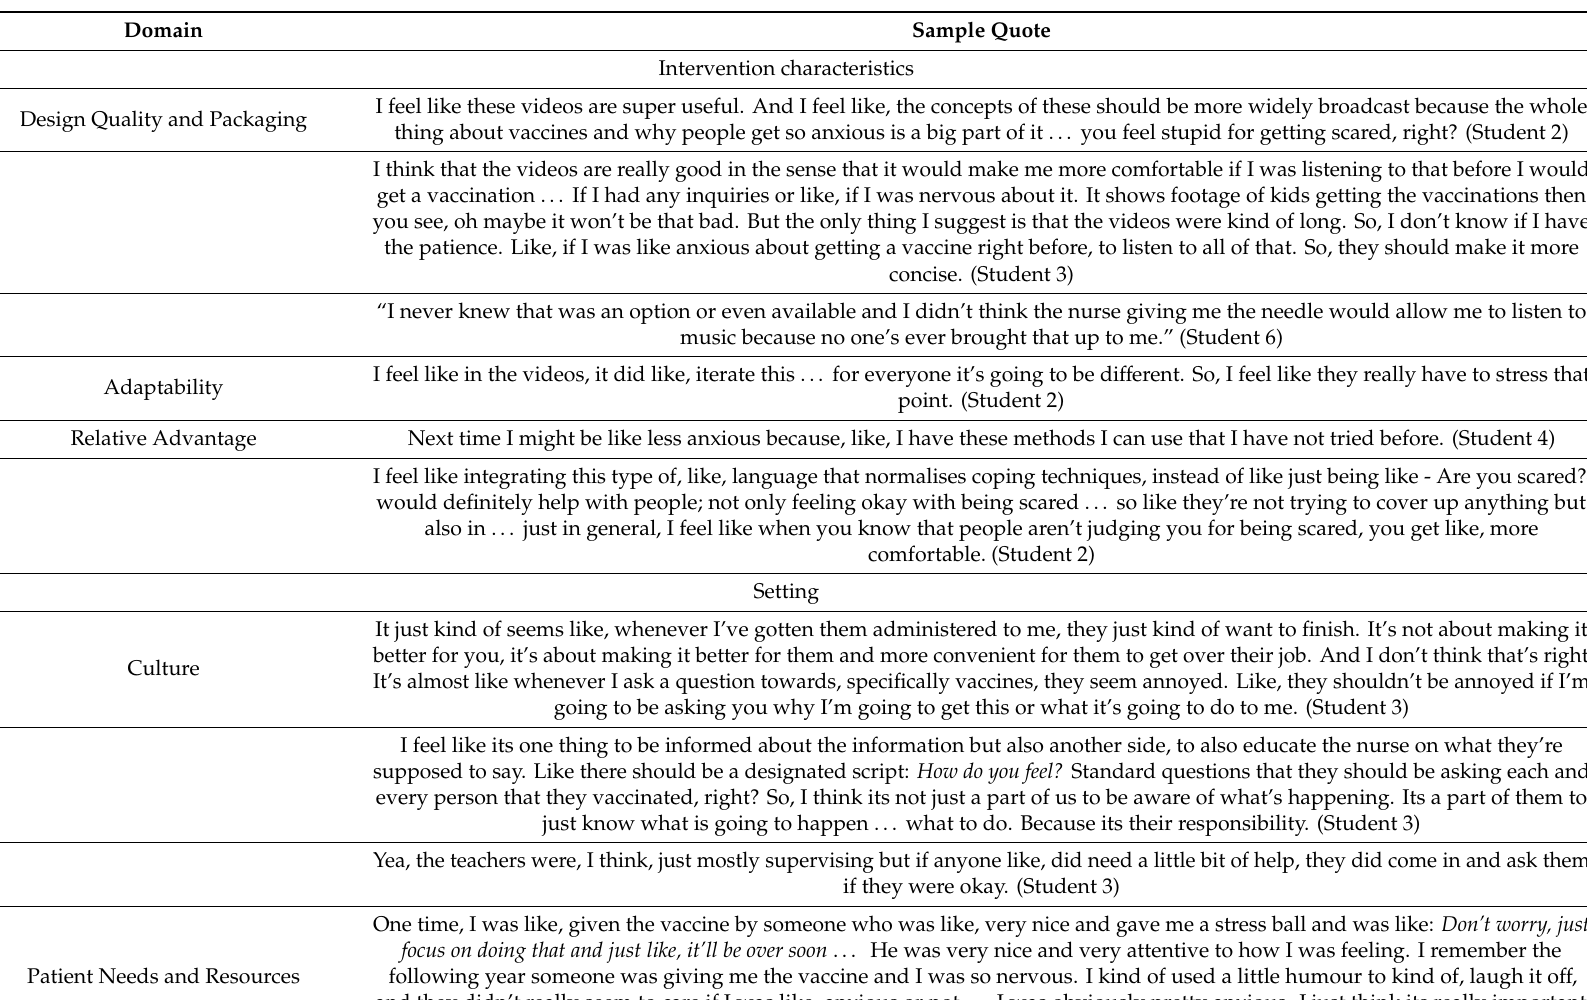
Table 1. Selected quotes from focus group discussion with students after review of educational materials ( n =